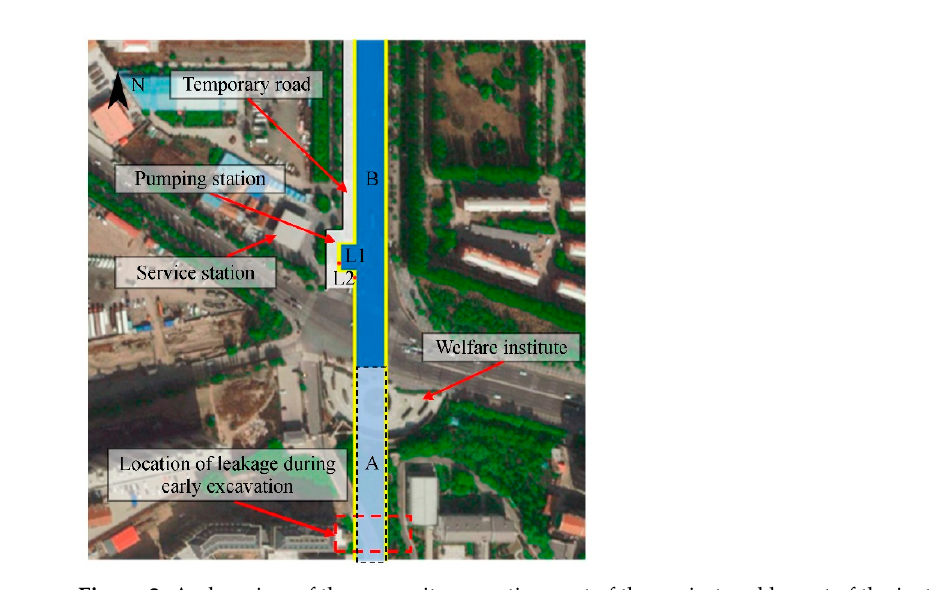
Figure 2. A plan view of the open pit excavation part of the project and layout of the instrumentation.